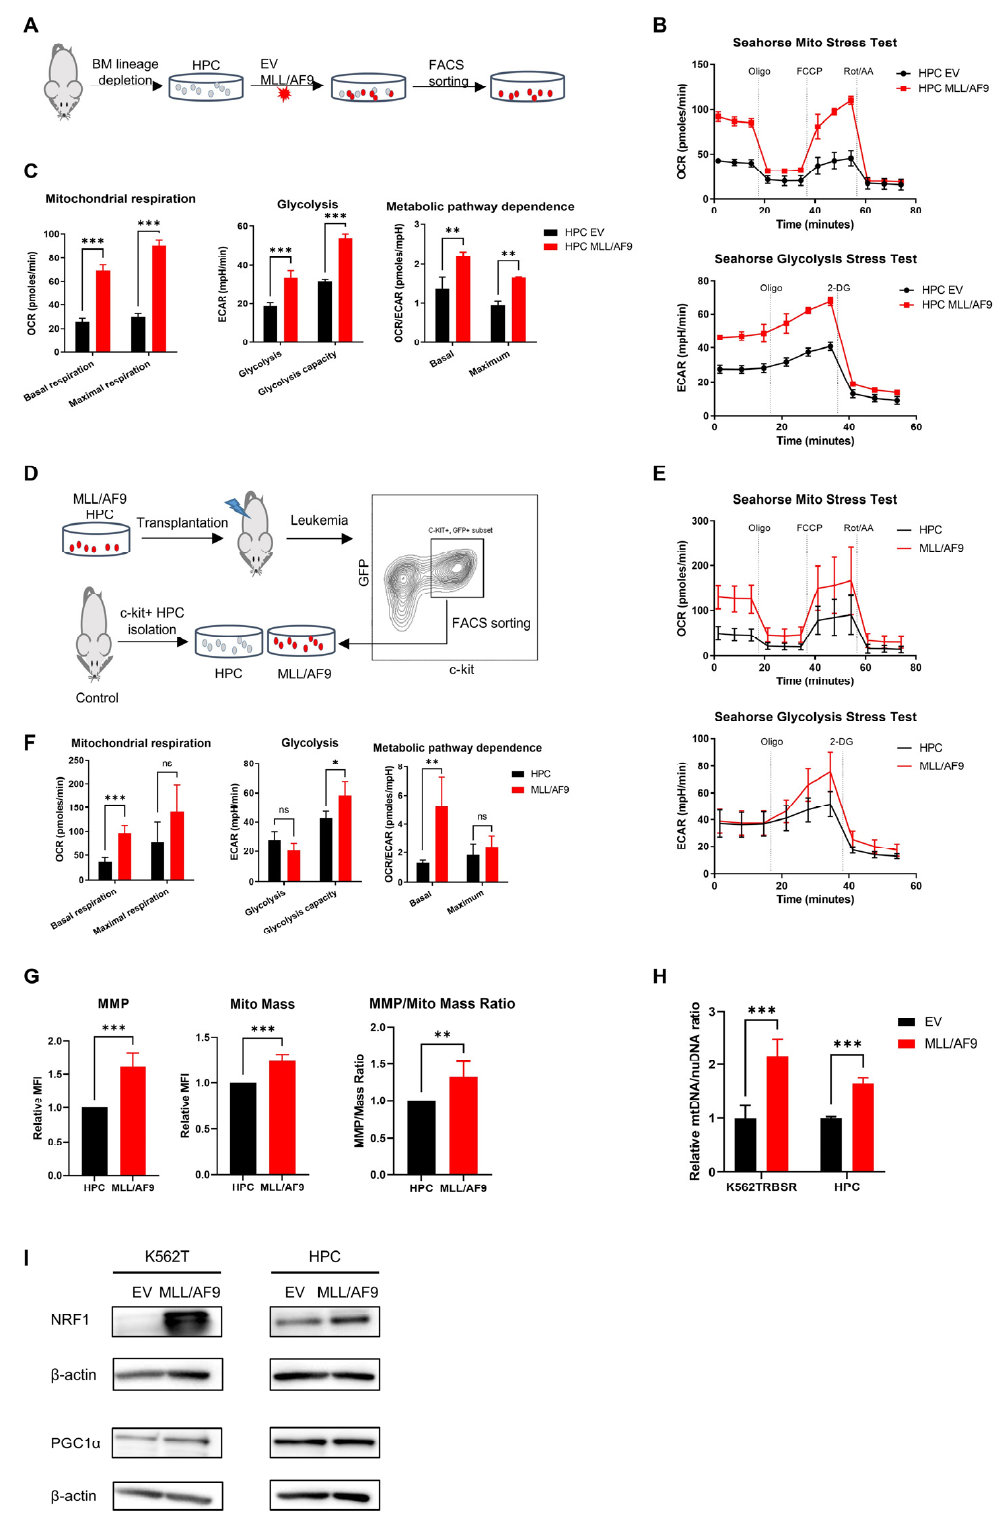
Figure 2. Metabolic phenotype of MLL/AF9 AML cells. Schematic outline of results obtained with the ex vivo ( A ) and in vivo ( D ) murine MLL/AF9 AML model. The experimental details are described in Materials and Methods. Seahorse Mito Stress Test and Glycolysis Stress Test were performed in murine HPCs transduced with empty vector (EV) or MLL/AF9 vector ( B ), and c-kit+/GFP+ blast cells from MLL/AF9 AML mice or c-kit+ HPCs from control mice ( E ). Mitochondrial respira- tion, glycolysis and metabolic pathway dependence were calculated accordingly in murine HPCs transduced with EV or MLL/AF9 vector ( C ), and in c-kit+/GFP+ blast cells from MLL/AF9 AML mice or c-kit+ HPCs from control mice ( F ). ( G ) Mitochondrial membrane potential (MMP), mitochondrial number (mito mass) and MMP/mito mass ratio were determined by flow cytometry in c-kit+/GFP+